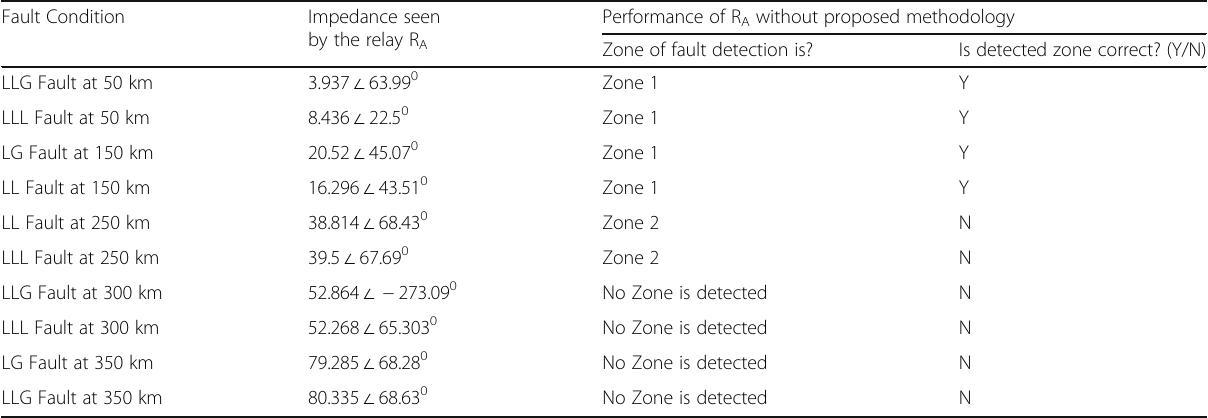
Table 6 Performance of distance relay R A without PAZSD methodology for different faults with FR = 4.9 Ω at different distances Fault Condition Impedance seen by the relay R A